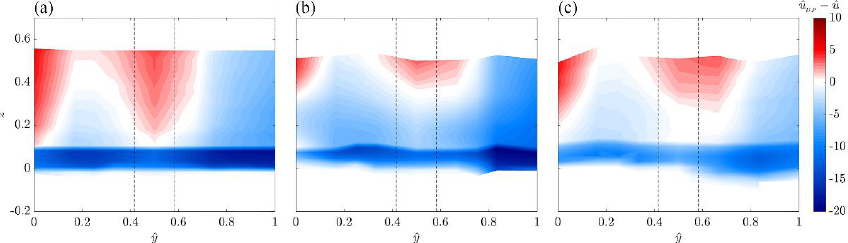
Figure 5. Contours of the dimensionless time-averaged accelerated (𝑢̂ 𝑈𝑃 −𝑢̂) < 0 and decelerated (𝑢̂ 𝑈𝑃 −𝑢̂) > 0 flow field in the upstream plane section (from LE to RE) for ( a ) Run 1, ( b ) Run 2 and ( c ) Run 3. The black dashed lines show the cylinder position.